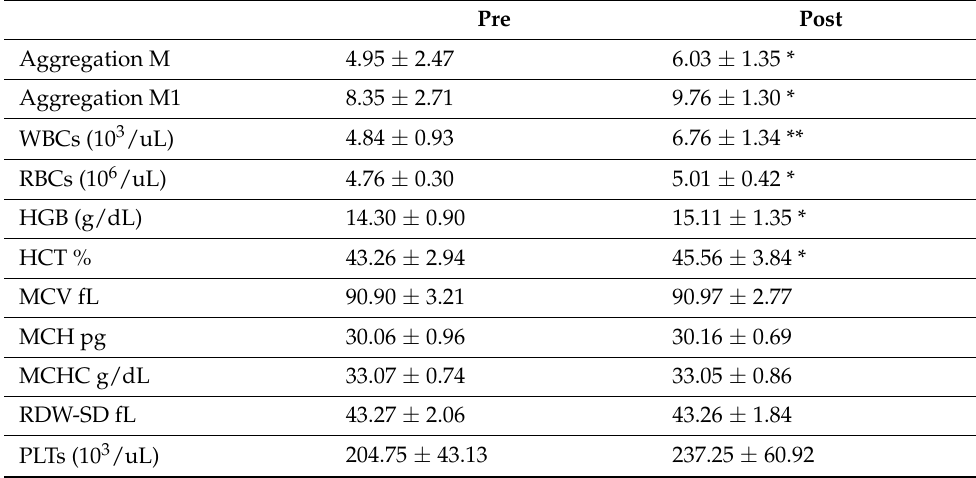
Table 2. Hematological and hemorheological results.